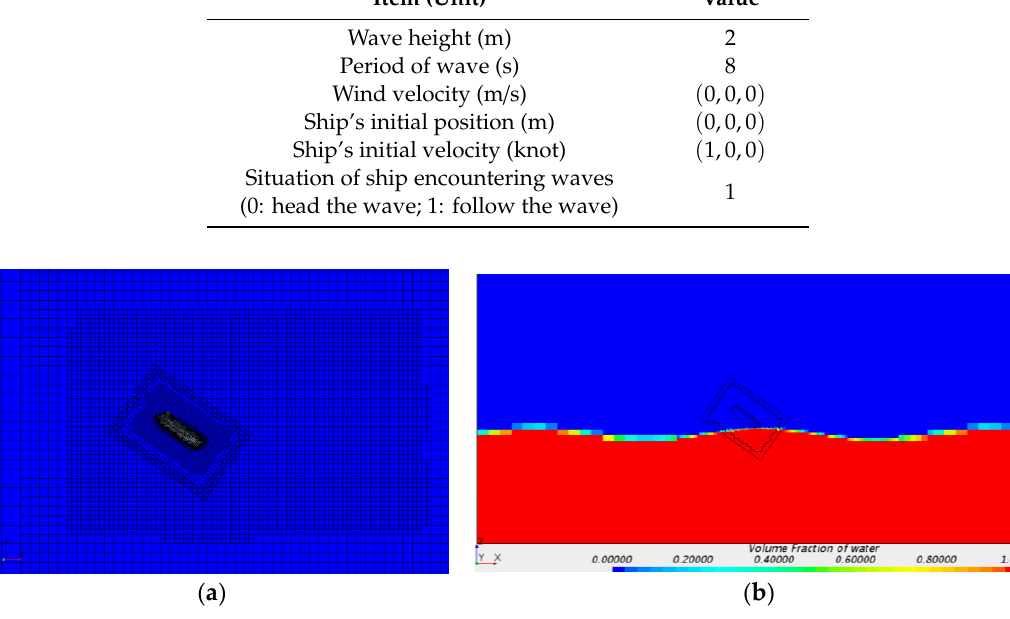
Figure 6. Simulation experiment diagram of Star CCM+: ( a ) overlapping grid; ( b ) volume fraction of water.